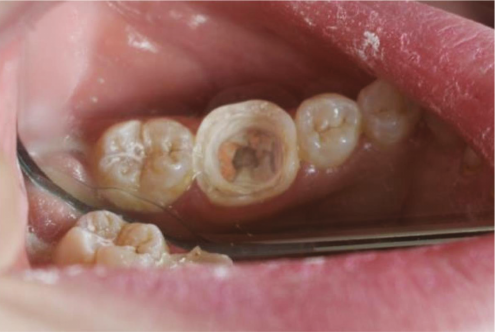
Figure 3: The molar after removal of the restoration.